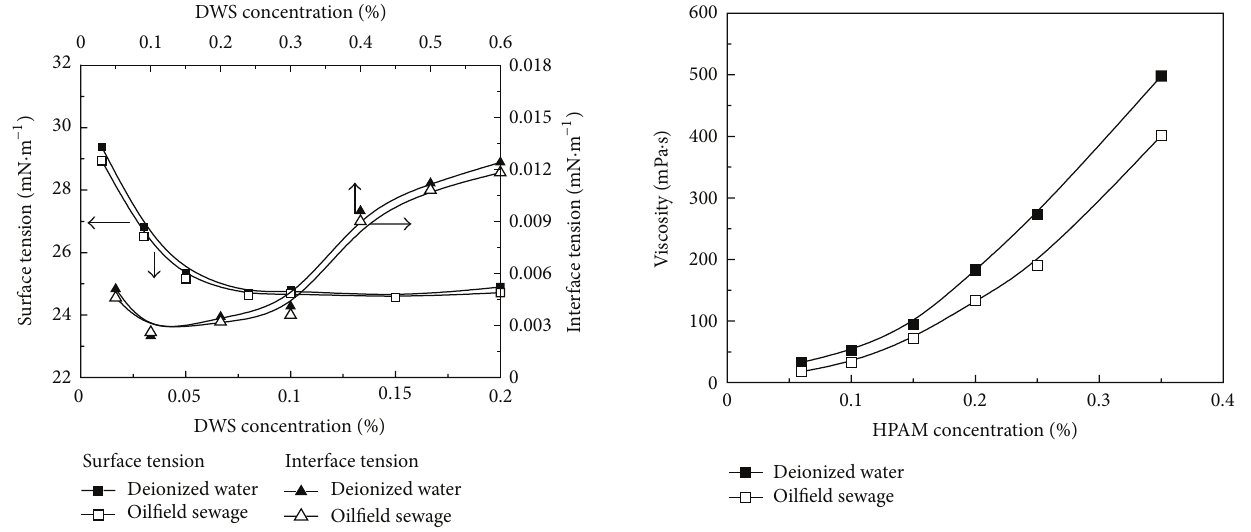
Figure 2: Surface and interfacial tensions of DWS.